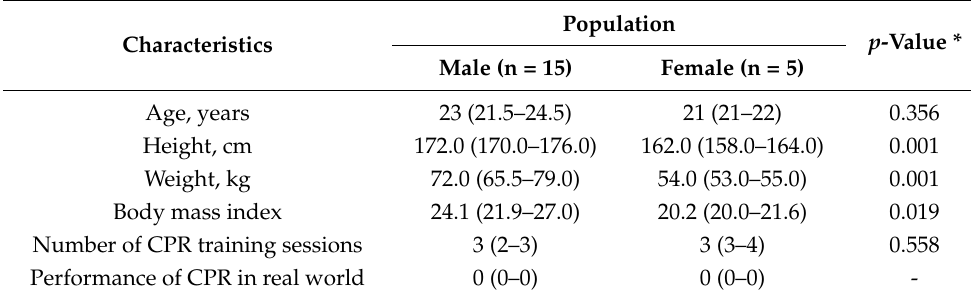
Table 1. Baseline characteristics of the study